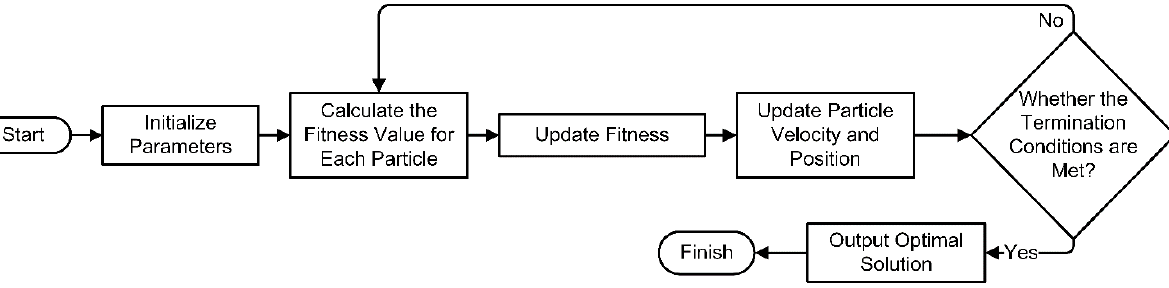
Figure 12. Flow chart of particle swarm algorithm.